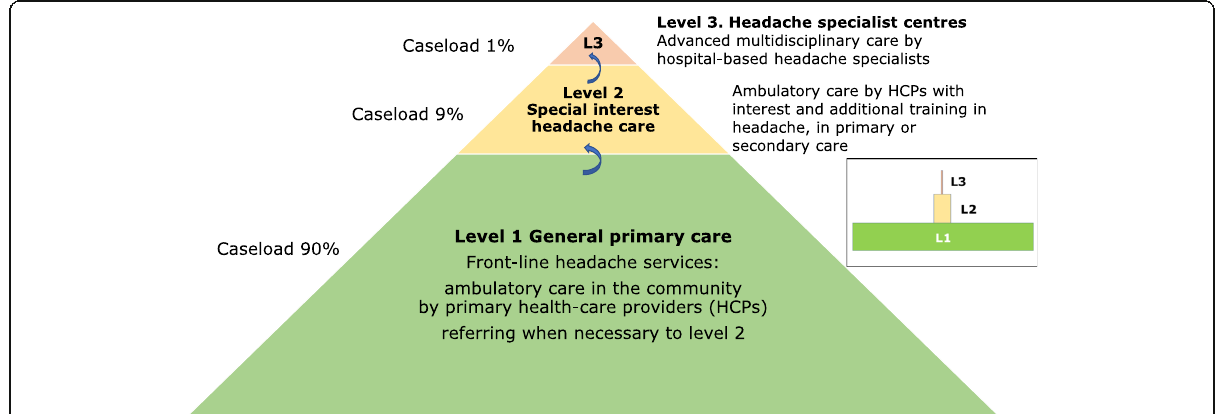
Fig. 1 Graphic depiction of headache services organized on three levels, but based in primary care, with predicted caseloads (see text and Table 3 for explanation). Inset: arguably a better